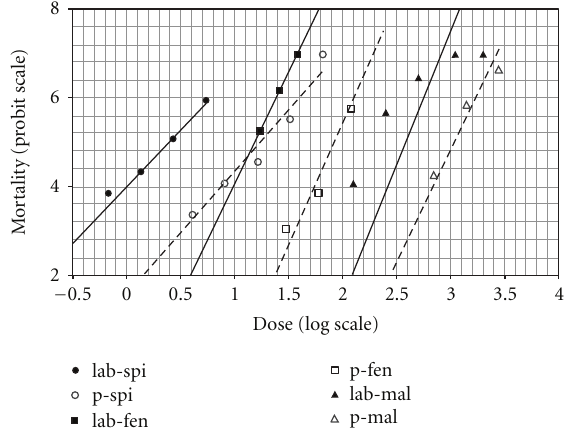
Figure 1: Dose-mortality regression line for spinosad, fenthion, and malathion by topical application in susceptible B. cucurbitae flies (solid line) and Pintung (dashed line) populations in